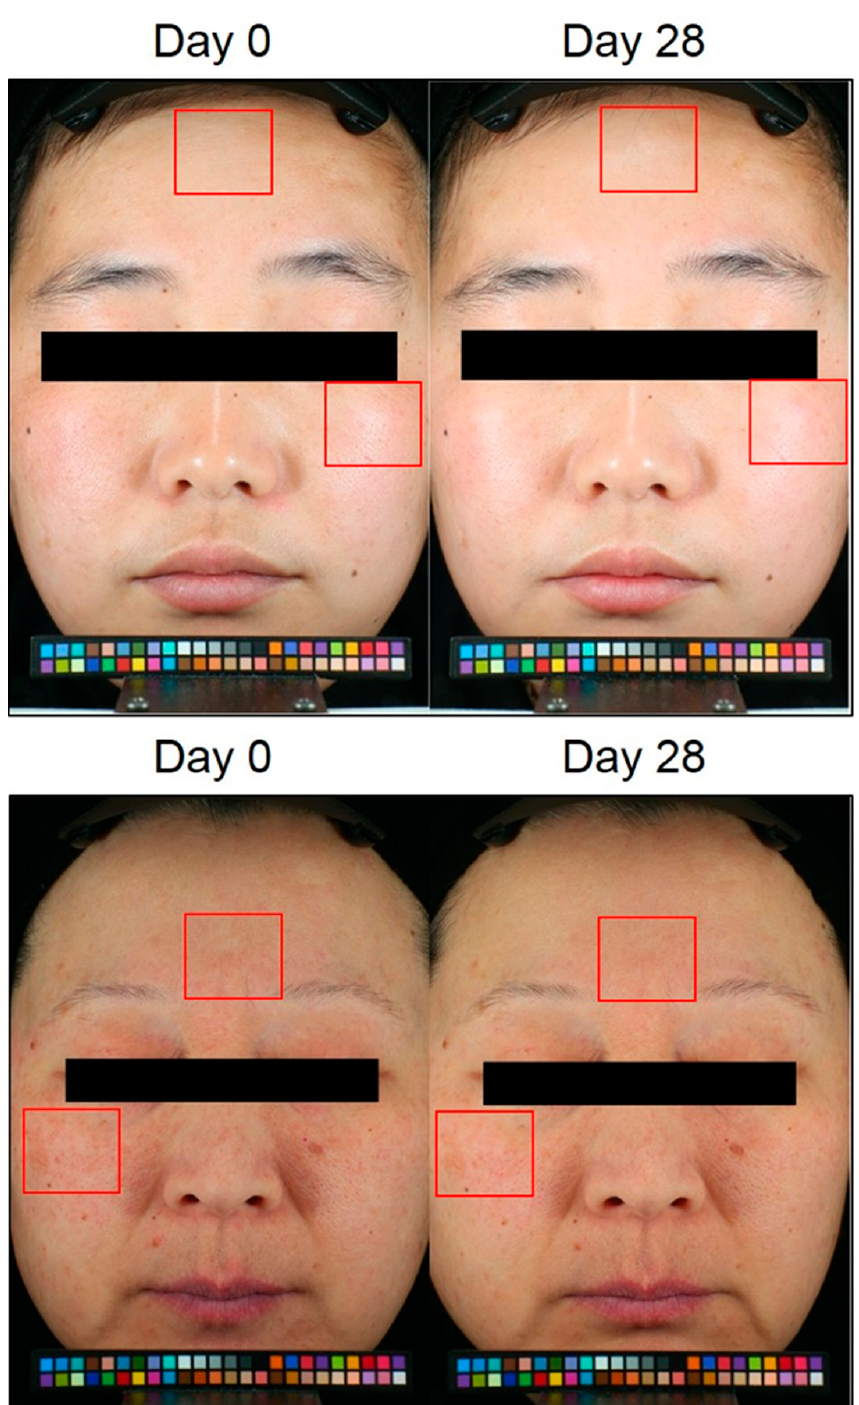
Figure 5. Clinical study utilizing E-AGSE showed improvement in anti-aging, hydration, and